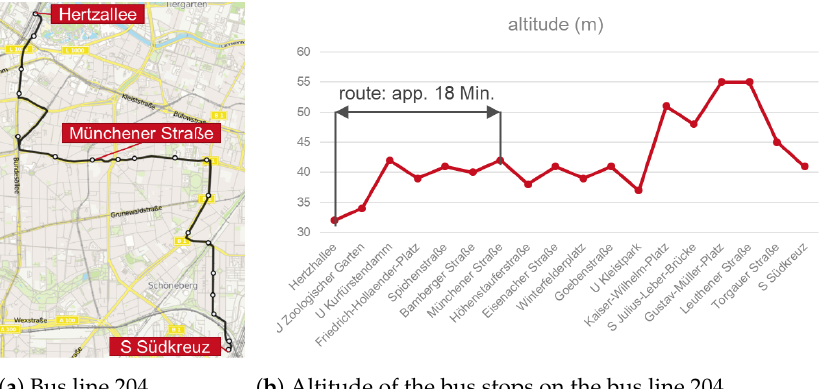
Figure 5. Employed route for the measurements. The bus line 204 ( a ) and the altitude of the stops on the line ( b ) are